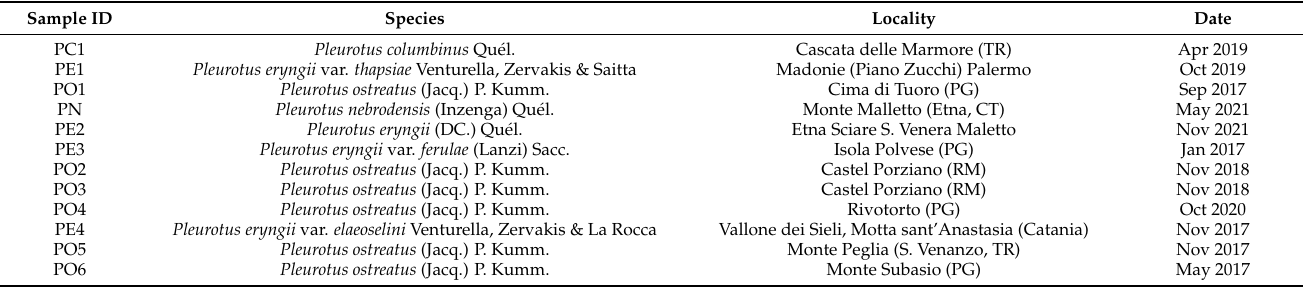
Table 1. Sample ID and data relating to the location and date of collection of Pleurotus species studied.